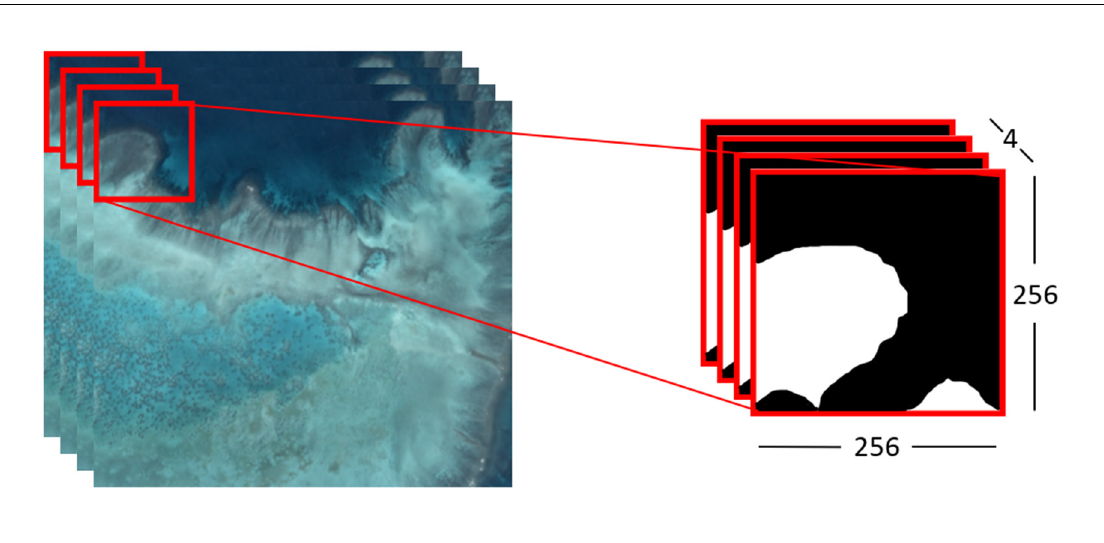
Figure 7. Example of a 256 × 256 × 4 training samples representing the class ‘coral’ (white) used as input to a CNN. The values 256 × 256 represent height and width in pixels while 4 represents the depth/number of bands in the multispectral image. The 256 × 256 × 4 sample is first extracted from the satellite image on the left. Next, all ‘coral’ pixels (white) are masked in order to assign the value of 0 to all non-coral pixels (black) from the training sample.